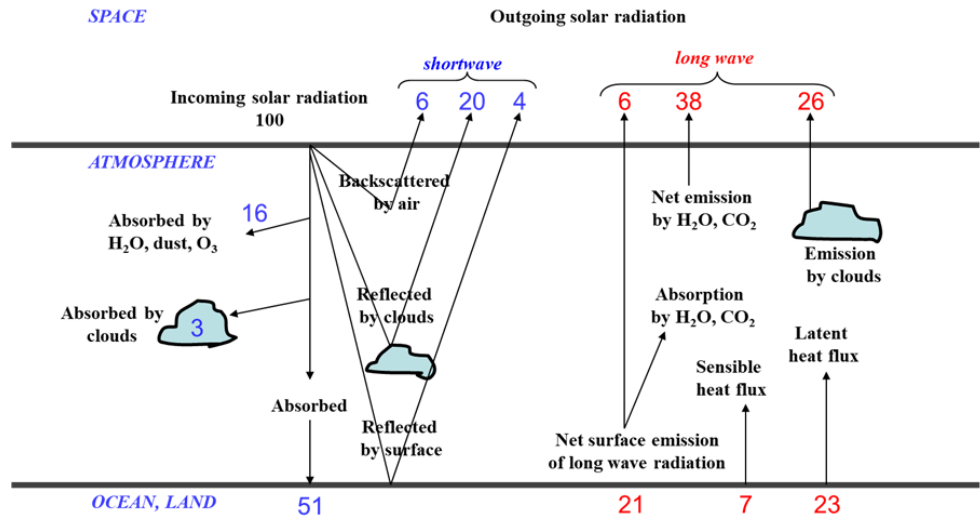
Figure 2. Radiation and heat balance in the atmosphere and Earth’s surface (global average compo- nents of the Earth’s energy balance) [15].